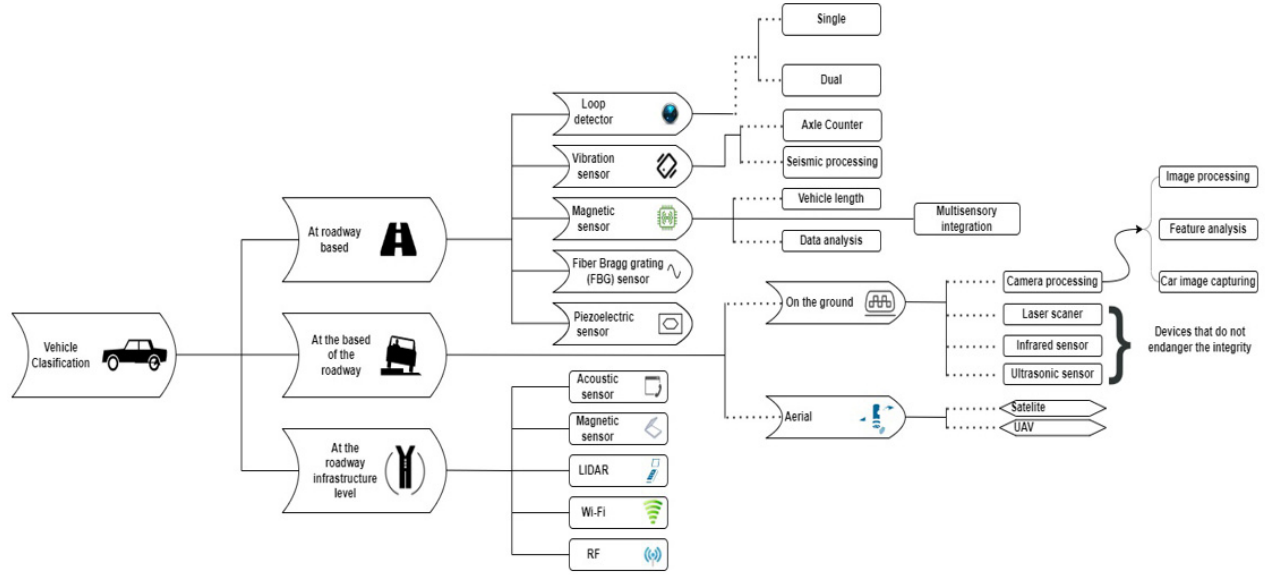
Figure 1. Vehicle classification systems diagram.